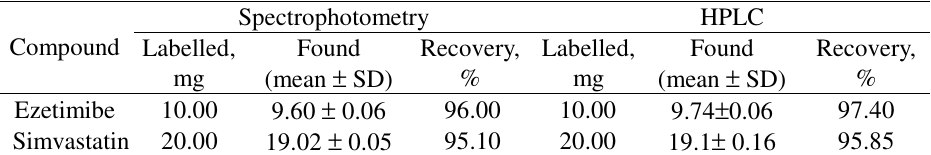
Table 5. Results of the analysis of commercial product containing ezetimibe and simvastatin by first order derivative